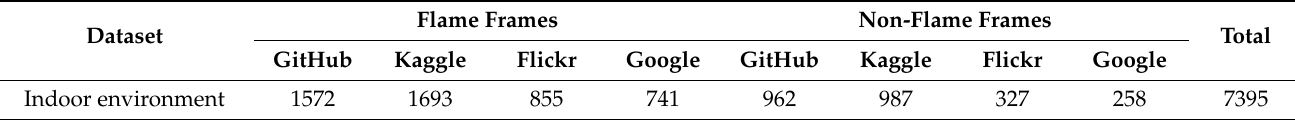
Table 1. Dataset distribution for fire classification research.